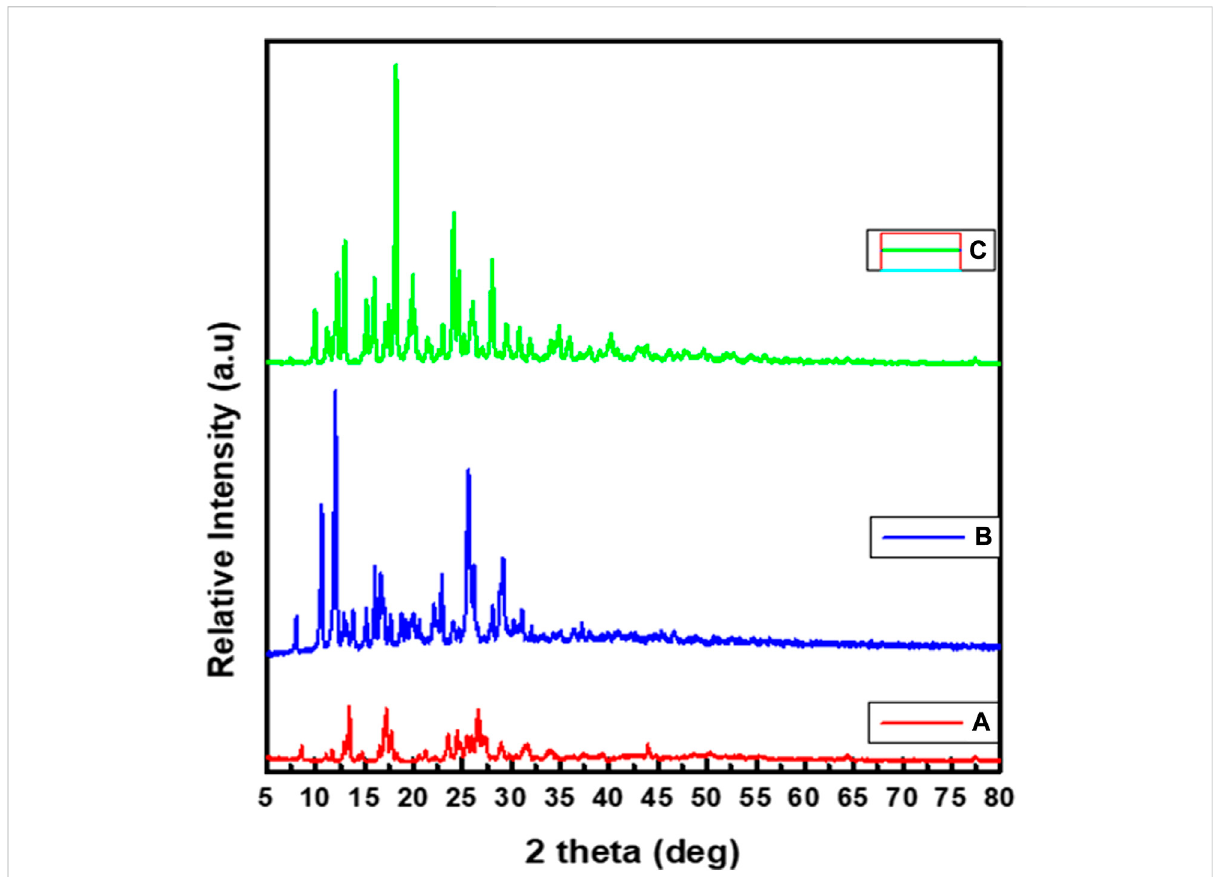
FIGURE 3 Powder XRD spectral data of: (A) Zn(II), (B) Cu(II) and (C) Ni(II) complexes.